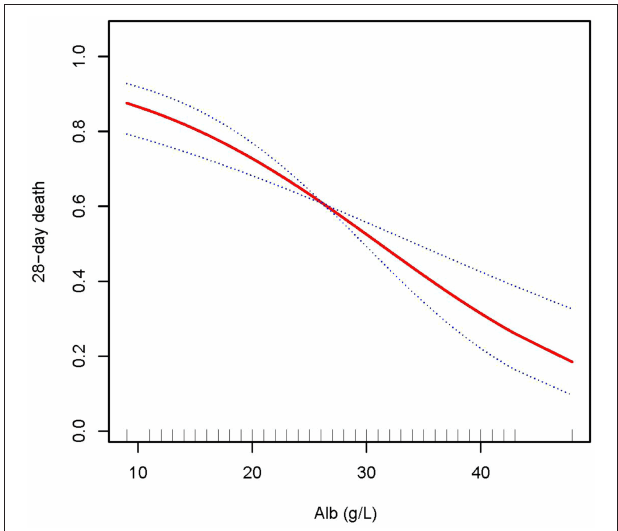
FIGURE 4 | Adjusted smoothing function of ALB for delta phosphate. After adjusting for age, gender, body mass index (BMI), Charlson comorbidity index (CCI score), C-reactive protein (CRP), white blood cell (WBC), hemoglobin (HB), K + , HCO 3 − , acute kidney injury (AKI) cause, continuous renal replacement therapy (CRRT) cause, (acute kidney injury network (AKIN) stages, CRRT dose, 2h urine output before CRRT initiation, and sequential organ failure assessment (SOFA) score, curve fitting analysis showed that delta phosphate increased as the ALB